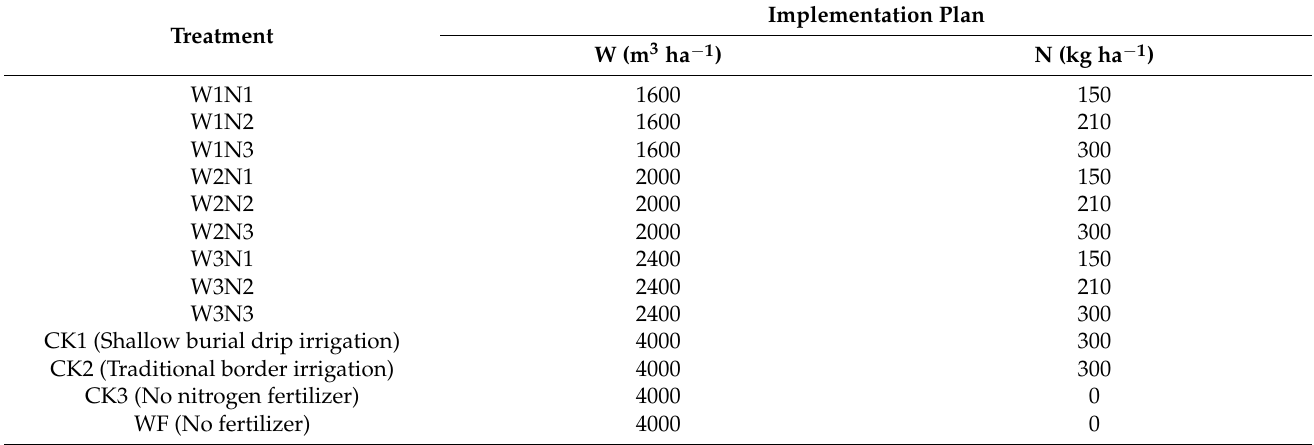
Table 6. Experimental design